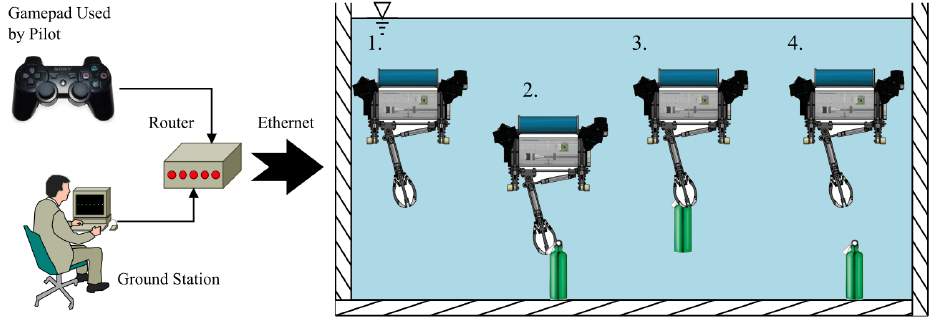
Figure 13. The proposed experimental procedure, where it is visible how the robot began from the ground station. The robot went through four stages: 1. the first was starting to submerge, 2. the second was taking the object, 3. the third was taking off at different depths, and 4. the last was carrying the object and releasing it in a different